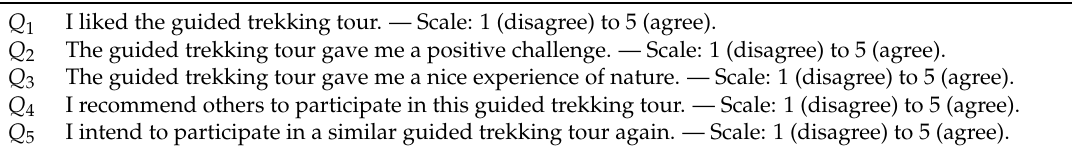
Table 3. Formulation of the satisfaction questions and